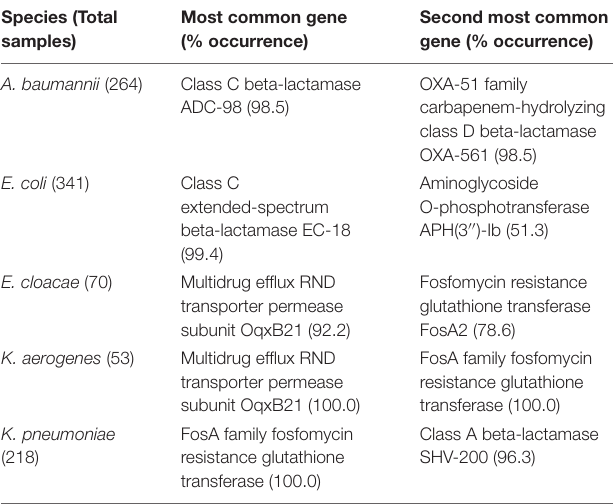
TABLE 2 | Most common antibiotic resistance gene clusters per species detected from the WGS data. Species (Total samples)